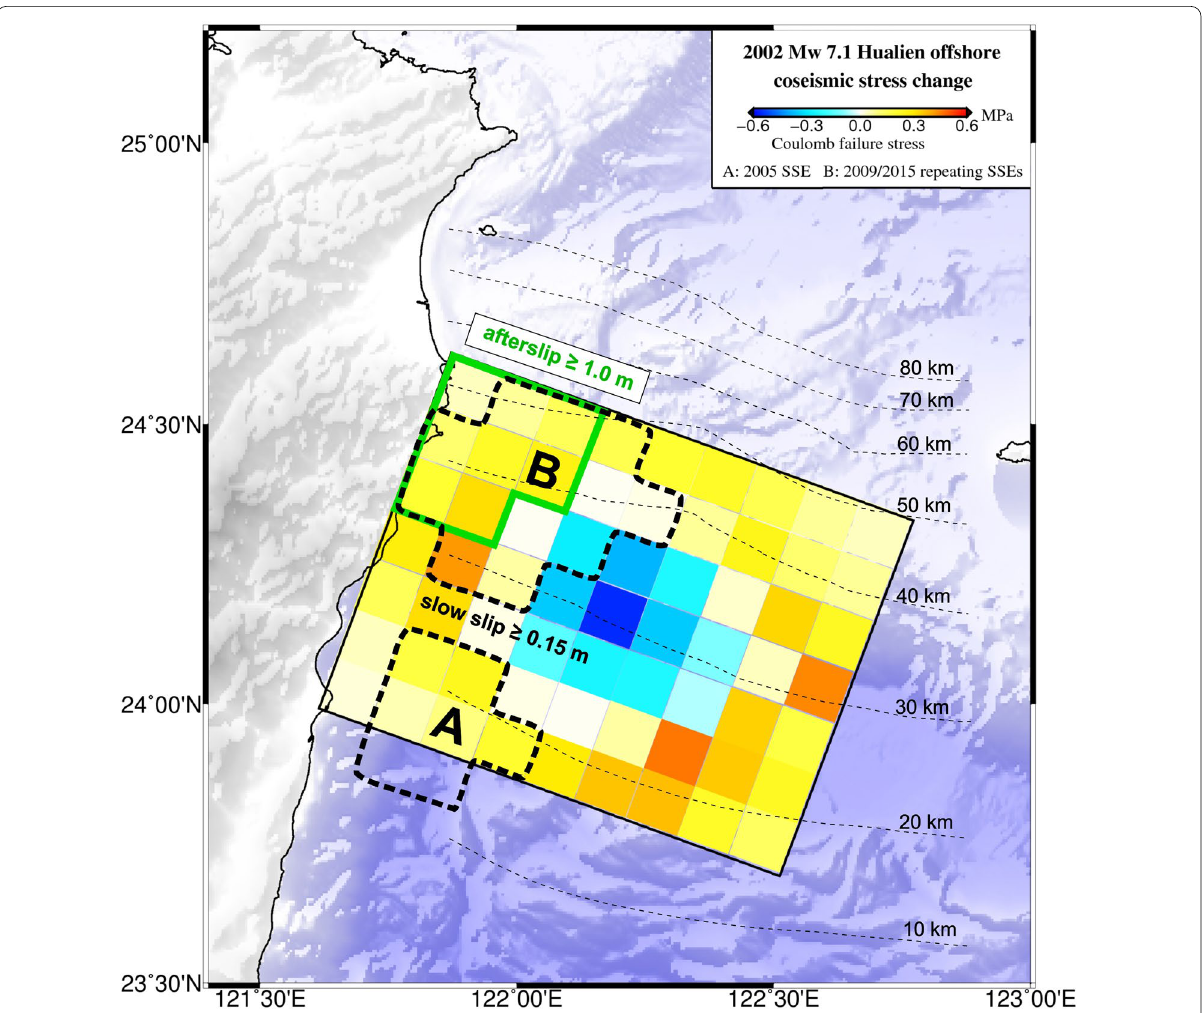
Fig. 4 Coulomb stress change caused by the 2002 M w 7.1 Hualien offshore earthquake. The black dotted rectangles represent the two SSE regions (zone A and B) with the cumulative slip which exceeds 0.15 m on the subducting plate interface (Chen et al. 2018). The green rectangle was the patch where the afterslip had exceeded 1.0